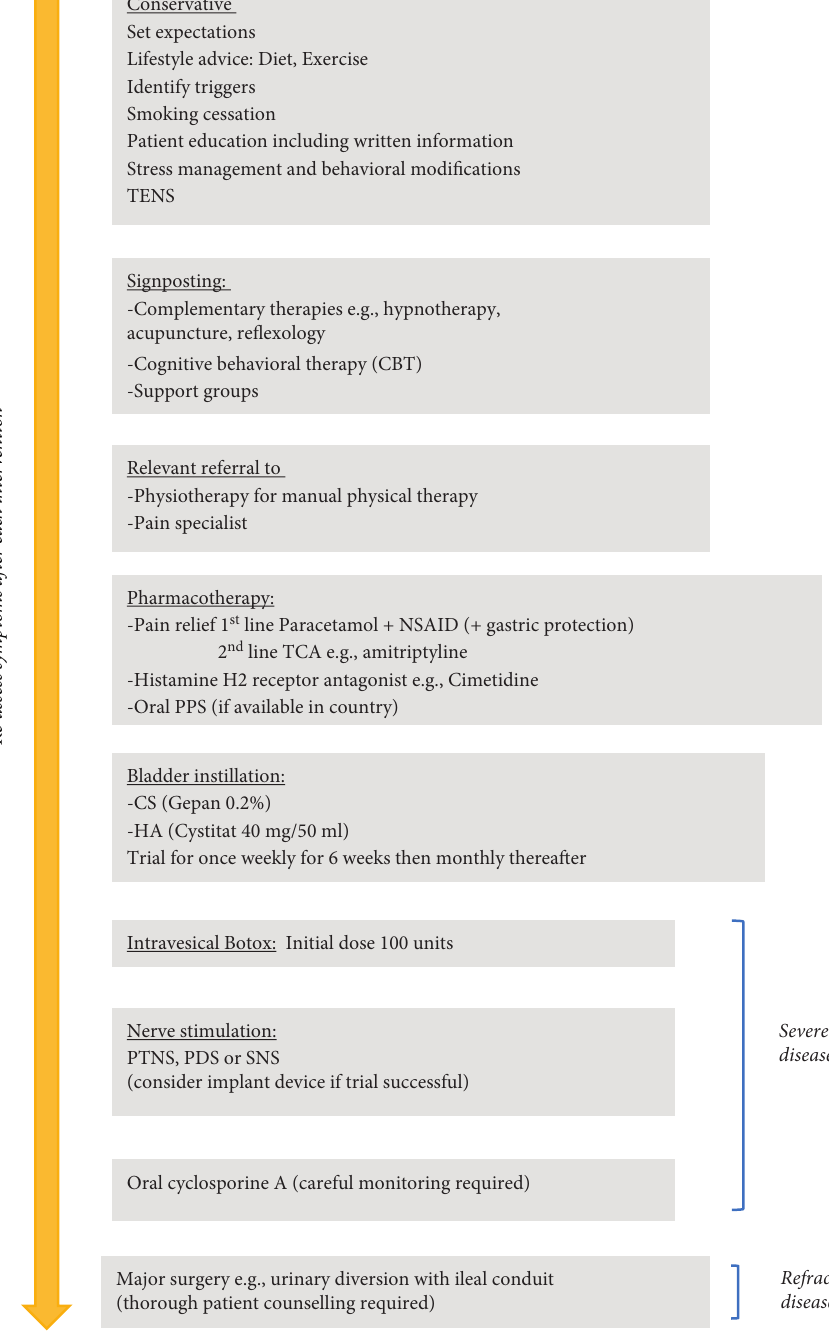
Figure 2: Treatment pathway for